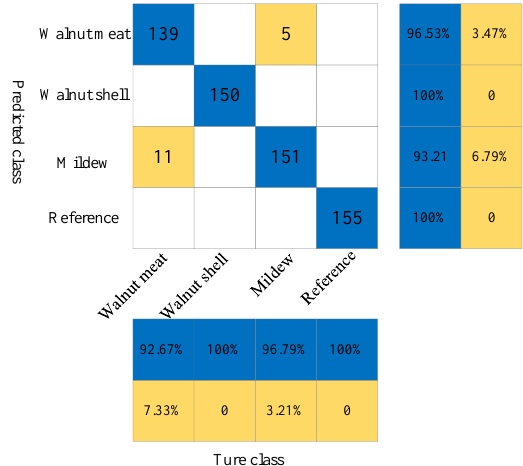
Figure 7. The confusion matrix of prediction results of walnut shell, walnut kernel, mildew sample and reference signal under RF model.